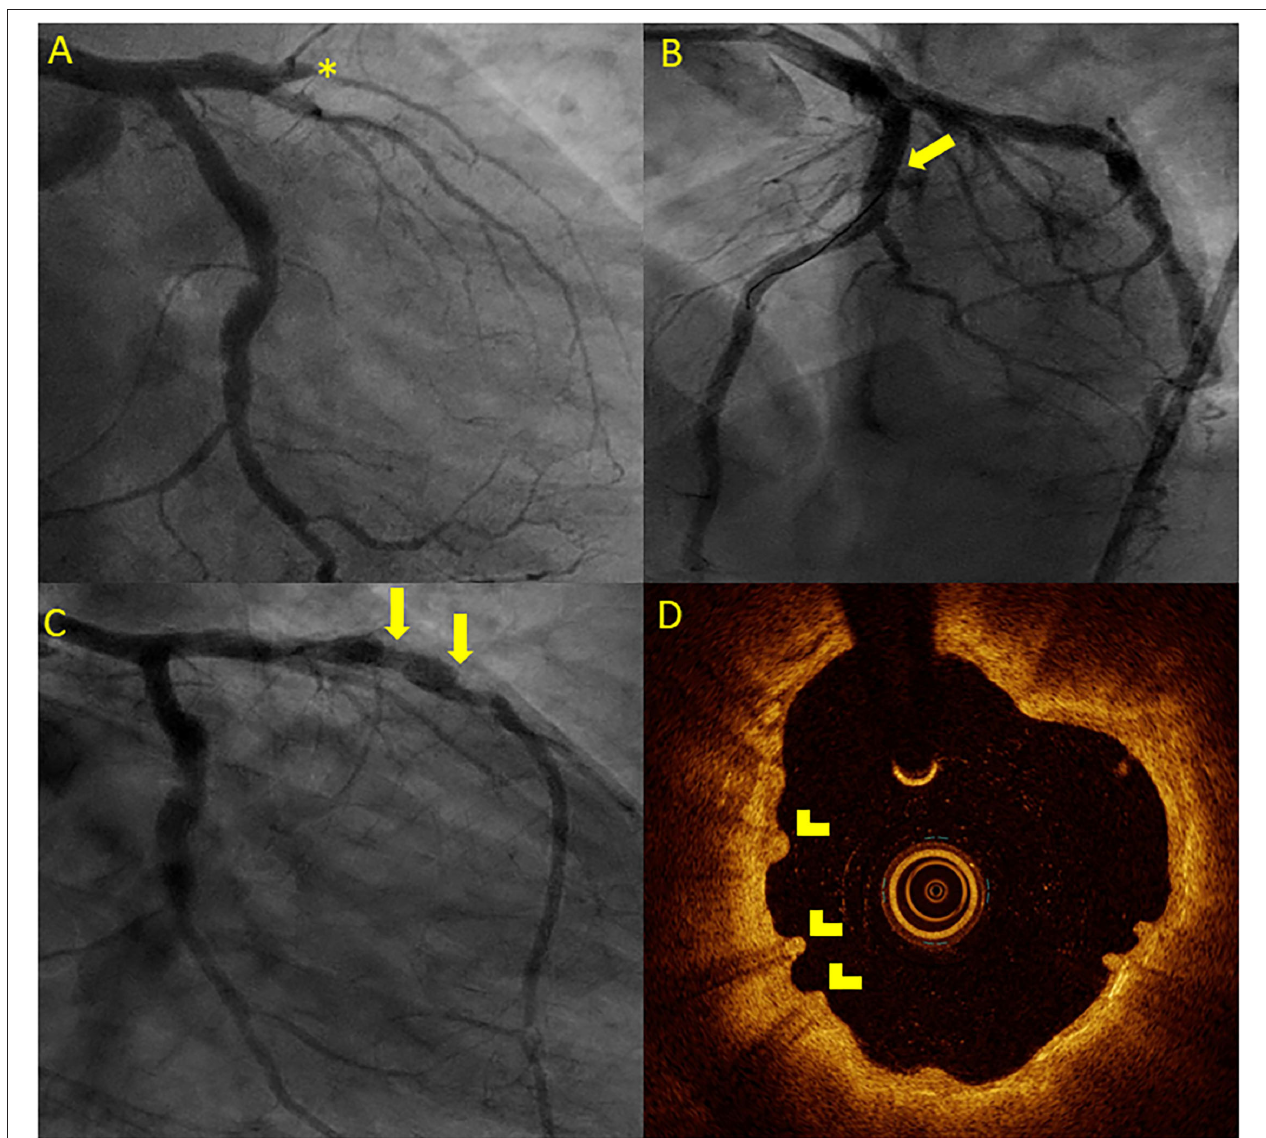
FIGURE 4 | Case vignette of a patient treated with the 2 Mg-BRS, depicting long-term scaffold persistence and negative vessel remodeling. A 46-year-old patient presented to the emergency department with an acute anterior ST-segment elevation myocardial infarction (STEMI). On the coronary angiogram, a complete occlusion of the mid LAD artery was observed (A) . After predilatation with a non-compliant balloon (2.5mm × 20mm, 14 atm), the 2 Magmaris BRS (3mm × 25mm and 3.5mm × 25mm) were successfully implanted (B) . The patient presented 4 years later with chest pain during physical activity [chronic coronary syndrome II (CCS II)]. On the coronary angiogram (C) , we found an aneurysmatic proximal to mid LAD without relevant stenosis. On OCT (D) , scaffold remnants were observed as an expression of incomplete scaffold degradation. *: complete vessel occlusion, arrow: coronary aneurysma, and arrowhead: scaffold remnants. (Figure 5). So far, the exact mechanisms leading to uncontrolled scaffold dismantling and discontinuities remain unclear.